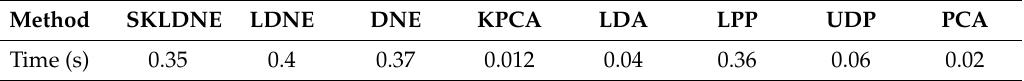
Table 7. The computational costs of the different classification methods using the Yale data base.